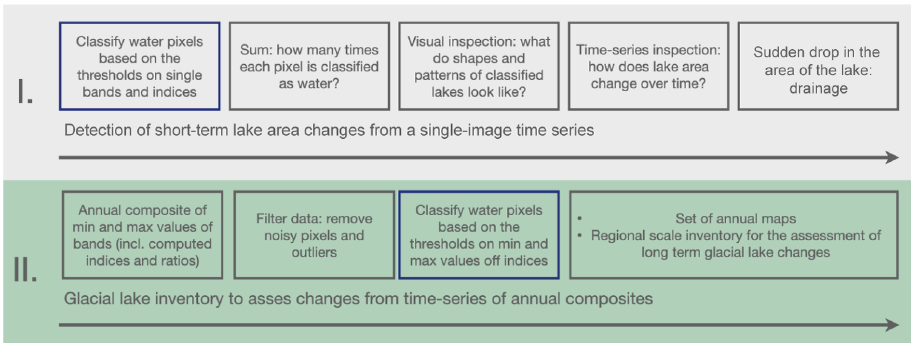
Figure 2. The core of the workflow for the proposed methods. ( I. ) identifying fast lake changes in a series of images; ( II. ) Compiling glacial lake inventory for glacial lake change assessment. Blue boxes indicate the ”water mapping”